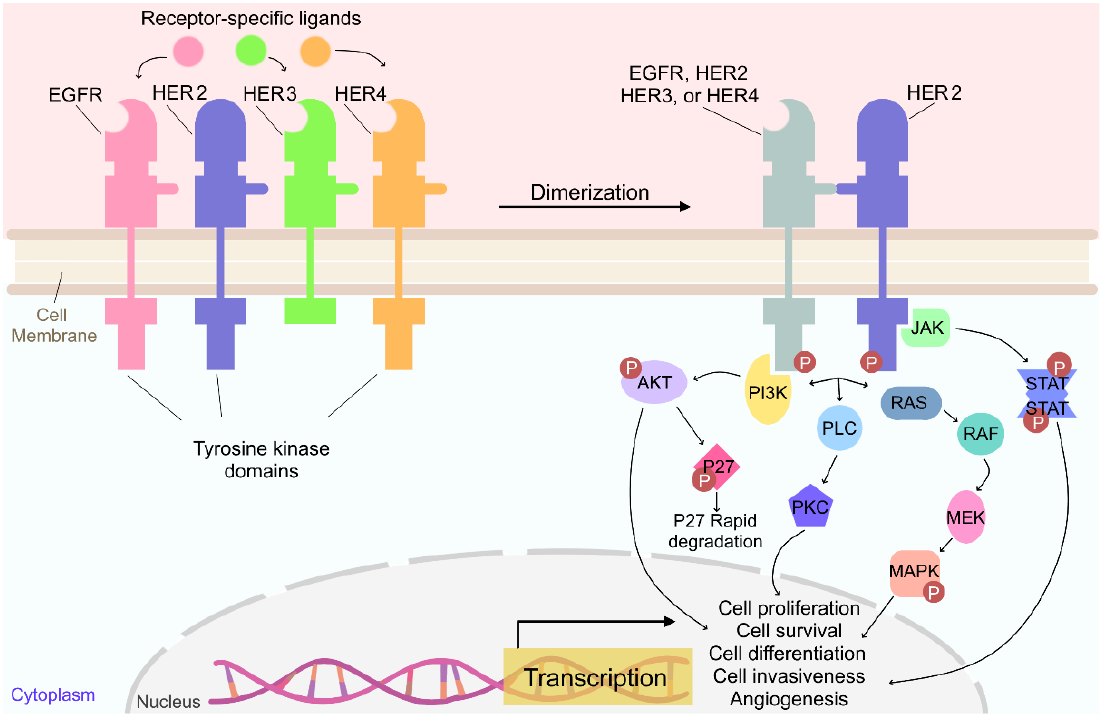
Figure 1. Overview of the HER2 signaling pathway. Unlike the other EGFR family of receptors, HER2 does not bind to any known ligands. Instead, HER2 is activated following heterodimerization with other activated EGFR family of receptors or by heterodimerization with activated HER2 recep- tors. Receptor dimerization leads to the phosphorylation of tyrosine residues and resultant signal transduction. PI3K/AKT, RAS/MEK/MAPK, JAK/STAT, and PKC are the most common signaling pathways through which several downstream cascades are activated, promoting numerous effects, including cell proliferation, survival, differentiation, angiogenesis, and invasion. Moreover, activated PI3K/AKT also leads to the degradation of cell-cycle inhibitor p27 Kip1 and thus promotes cell-cycle progression. EGF, Epidermal growth factor; HB-EGF, heparin-binding epidermal growth factor; TGF, tumor growth factor; NRG, neuregulin.